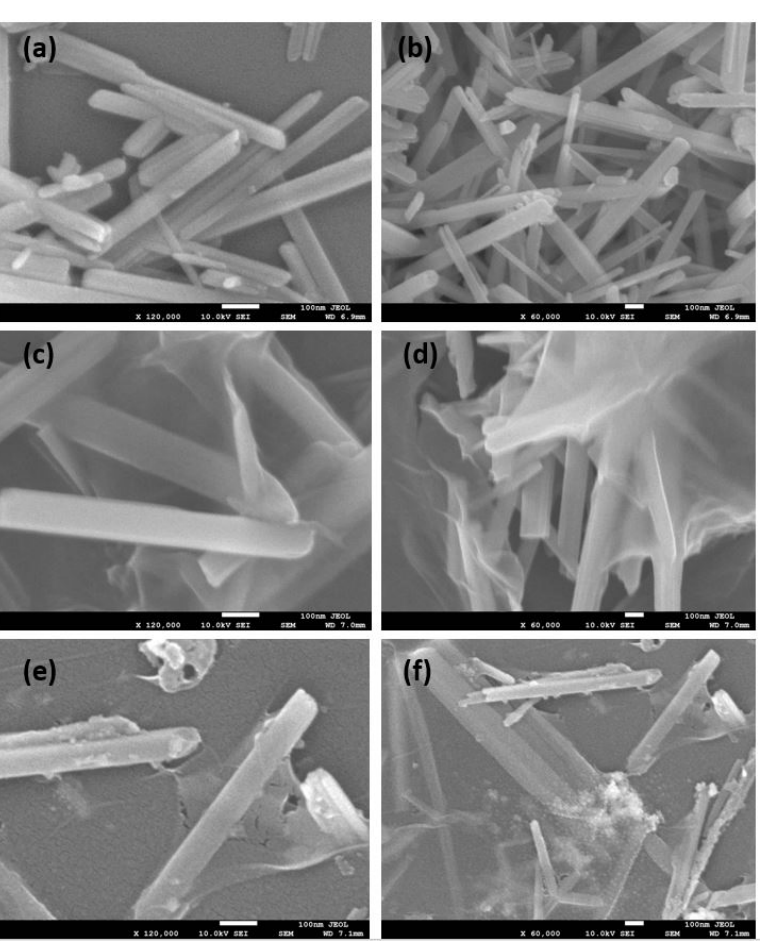
Figure 3. FESEM images of ( a , b ) pure MnO 2 rods, ( c , d ) rGO@MnO 2, and ( e , f ) Ag-rGO@MnO 2 nanocomposite at various magnification. The EDX spectrum of the MnO 2 rod shows the presence of Mn, O, and Pt. The binary rGO@MnO 2 shows Mn, O, C, and Pt, and the ternary Ag-rGO@MnO 2 nanocomposites show C, O, Mn, Ag, and Pt (Figure 4a–c). The observed additional elemental peak of Pt is due to the coated Pt to avoid charging during the scanning process, as shown in Table 1. Furthermore, the EDX mapping images confirmed the uniform distribution of C, O, Mn, and Ag in the Ag-rGO@MnO 2 nanocomposite (Figure 5a–f).